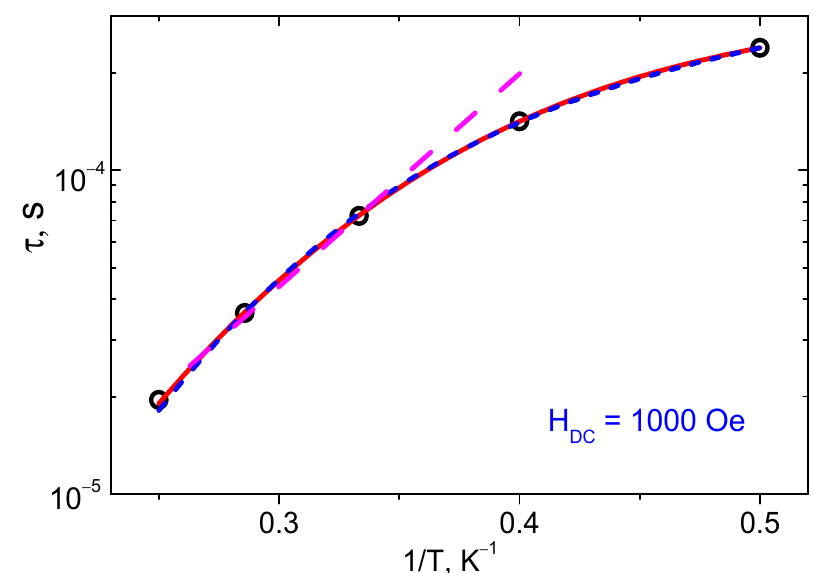
Figure 8. The dependence of the relaxation time τ on the reciprocal temperature 1/ T for 4 . The points are obtained by approximating the frequency dependence of χ″ by the generalized Debye model. The magenta dashed line represents the result of the fit by the Arrhenius equation, the red solid line corresponds to the sum of Raman and QTM processes, the blue dashed line corresponds to Raman and direct processes.